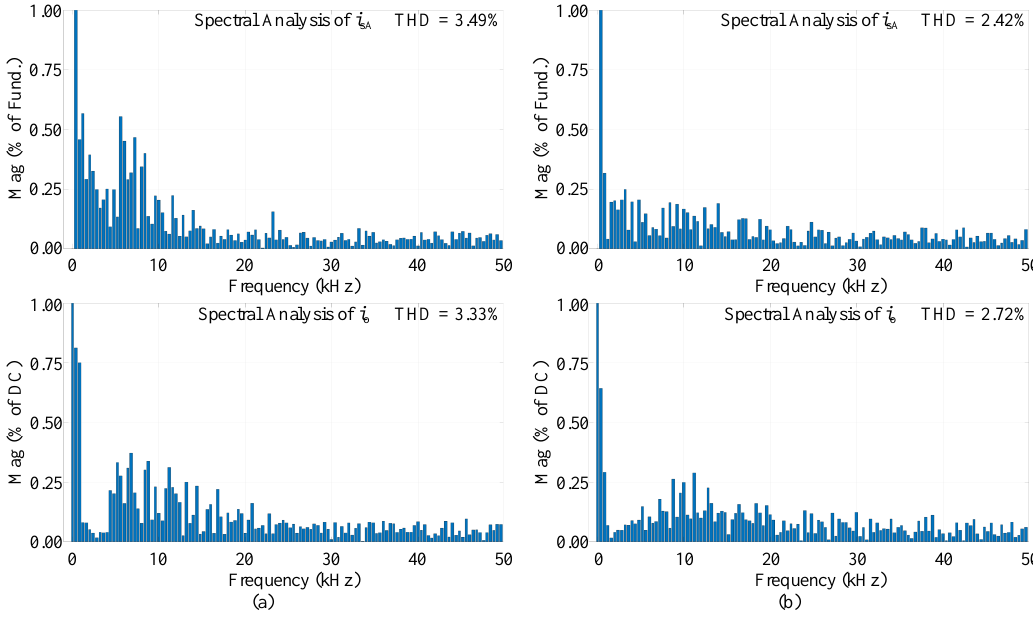
Figure 7. Spectral analysis results of source current i sA and output current i o : ( a ) the output sampling time T so was 333 s and ( b ) T so was 667 s.